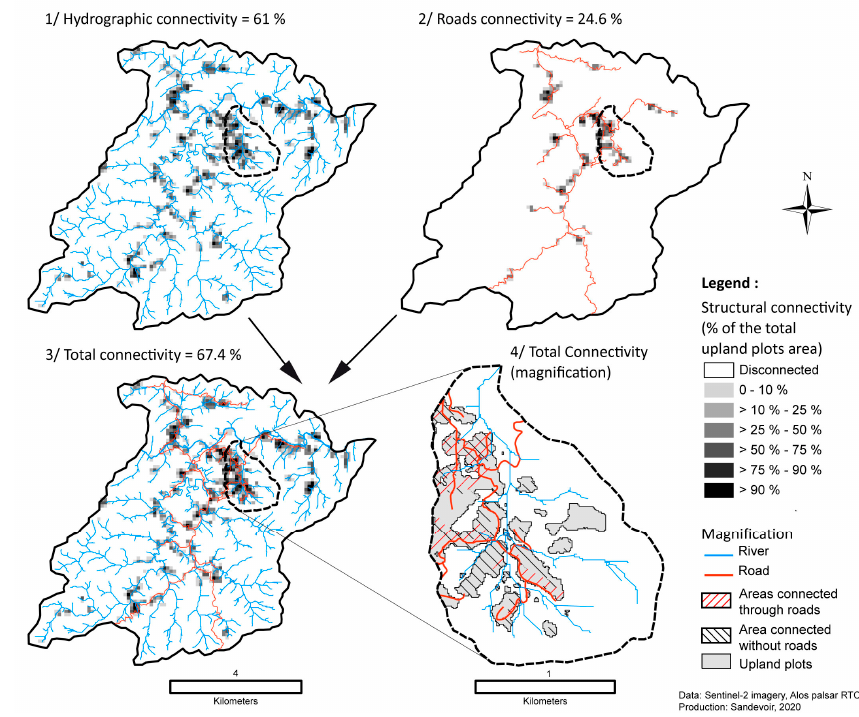
Figure 11. Structural connectivity modelling, linked to the maize cultivation expansion.